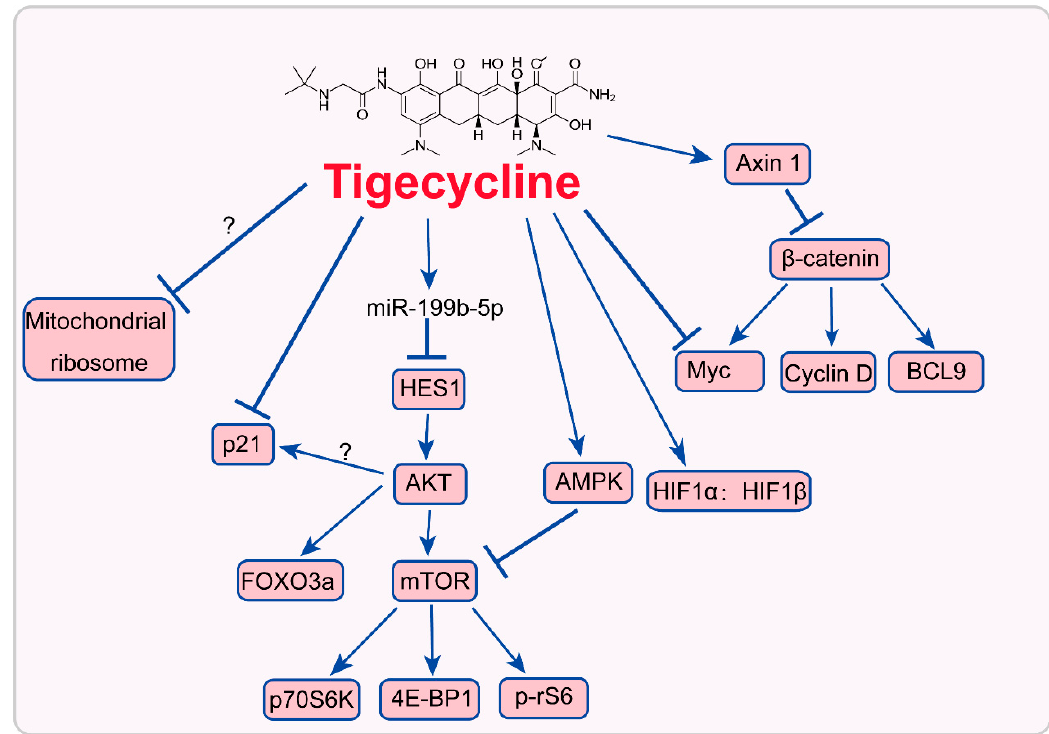
Figure 2. Mode of action of tigecycline in cancer cells. 4E-BP1, eukaryotic translation initiation factor 4E-binding protein 1; AMPK, AMP-activated protein kinase; BCL9, B-cell CLL/lymphoma 9; FOXO3a, forkhead box O3; HES1, hairy and enhancer of split homolog-1; mTOR, mammalian target of rapamycin; p70S6K, ribosomal protein S6 kinase; p-rS6, ribosomal S6 protein.